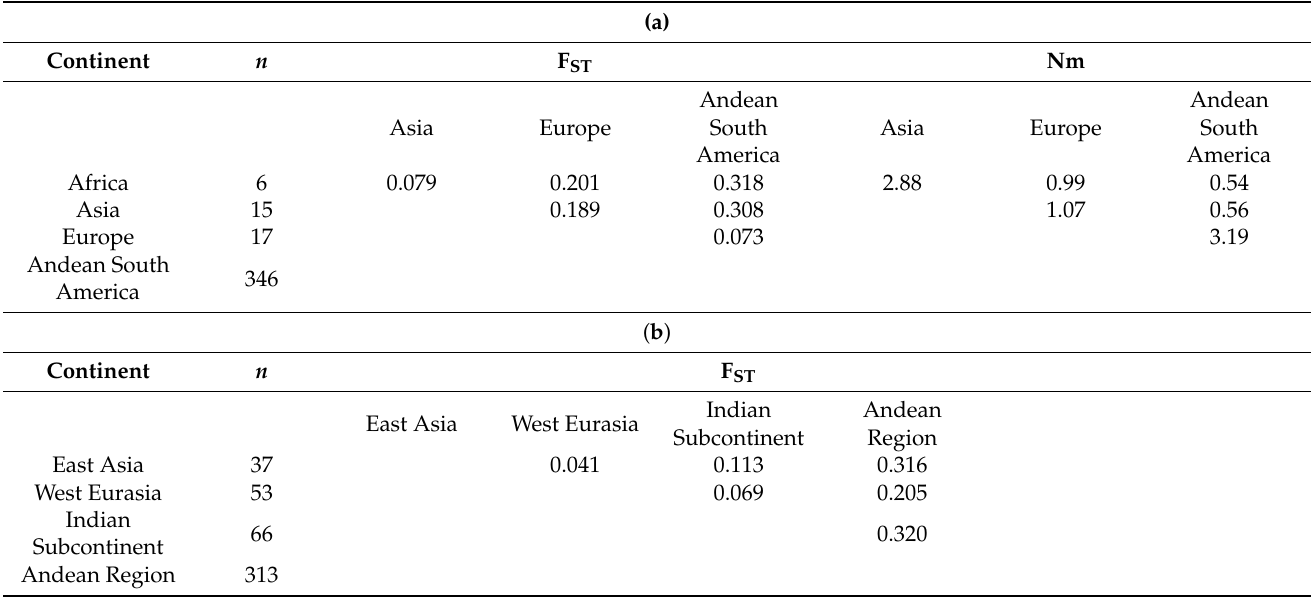
Table 3. Genetic links (gene flow) between the potato virus X concat populations. ( a ) Genetic links between the concat populations of different continents. ( b ) Genetic links (gene flow) between the coat protein (CP) gene populations of different